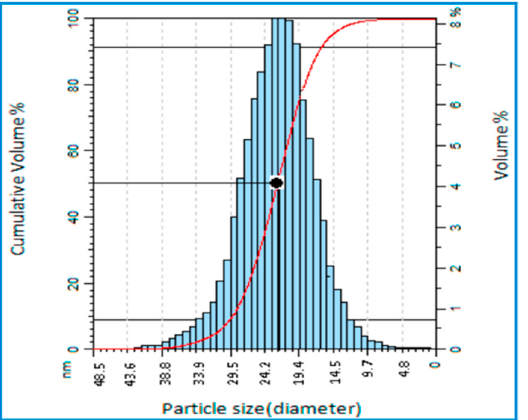
Figure 4. Particle Size Distribution analysis of ZnO shows an almost symmetric distribution at about 22 nm [33]. Reprinted from an open-access